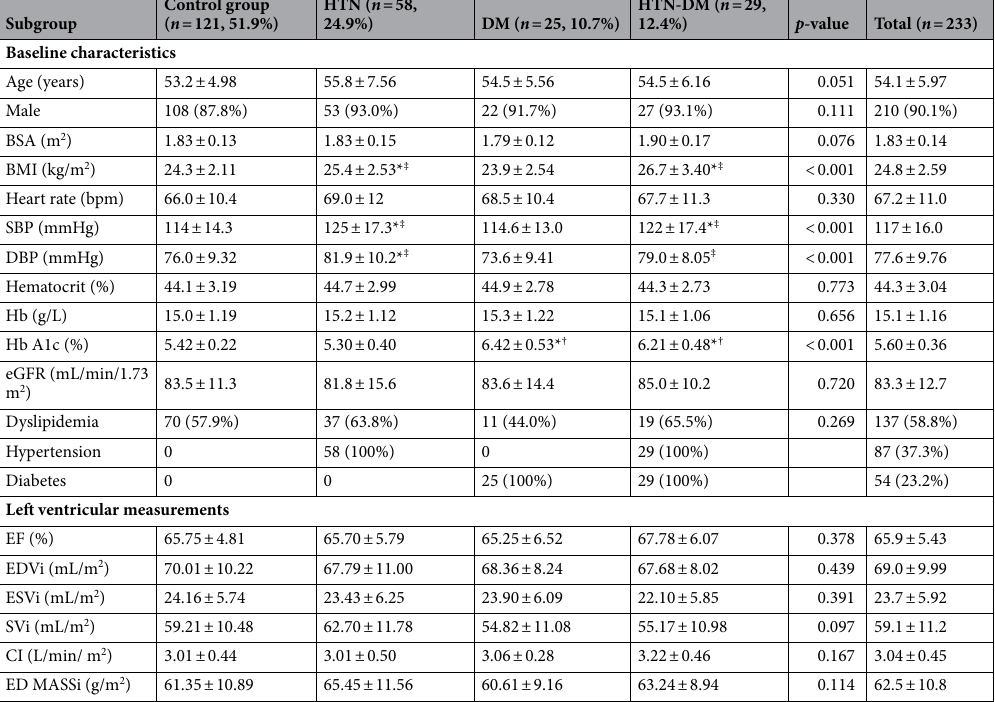
Table 1. Baseline characteristics and cardiac magnetic resonance measurements of study population. BMI body mass index; CI cardiac index; DM diabetes mellitus; DBP diastolic blood pressure; ED MASSi indexed end-diastolic myocardial mass; EDVi indexed end-diastolic volume; EF ejection fraction; ESVi indexed end- systolic volume; eGFR estimated glomerular filtration rate; Hb hemoglobin; HTN hypertension; SBP systolic blood pressure; SVi indexed stroke volume. Continuous values are presented as mean ± standard deviation. The proportion of a numeric value is described in parenthesis. * p < 0.05 versus control group. † p < 0.05 versus HTN group. ‡ p < 0.05 versus DM